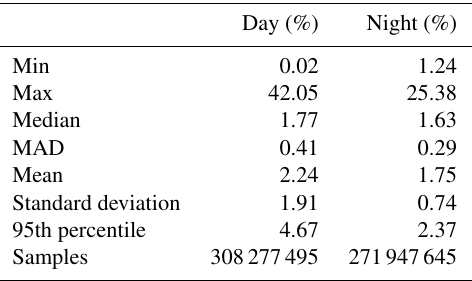
Table 2. Summary of CALIOP V4 single-profile relative calibra- tion coefficient uncertainties for all 1064nm attenuated backscatter profiles acquired during